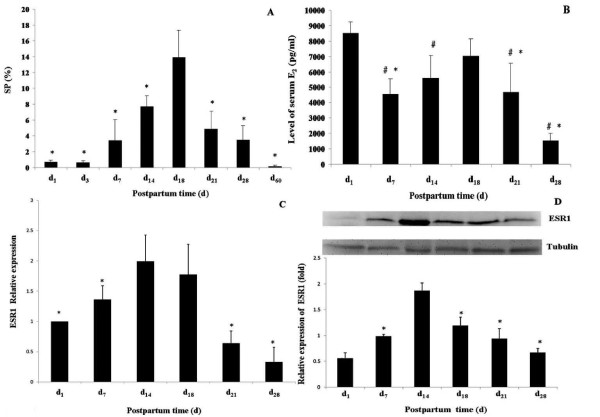
Proportion of SP cells and ESR1expression in postpartum mouse uterus, as well as serum E2 level, in postpartum mice at different day. Figure 1A. Proportion of SP cells in the uterus of postpartum mice at Day 1 to 60. *Compared with Day 18, P < 0.05. At Day 18, the proportion of SP cells was highest. Figure 1B. Levels of serum E2 in mice at different postpartum day. #compare to Day 1, P < 0.05; * compare to Day 18, P < 0.05. Levels of E2 in Day 1 and Day 18 were the highest. Figure 1C. Real-time RT-PCR analyses of ESR1mRNA expression in postpartum uterus. *compare to Day 14, P < 0.05. Expression of ESR1 mRNA in Day 14 was highest. Figure 1D. Western blot analyses of ESR1 expression in postpartum mouse uterus. ESR1 expression level at day1 was set as a standard as 1. *compare to Day 14, P < 0.05. Level of ESR1 protein in Day 14 was highest.